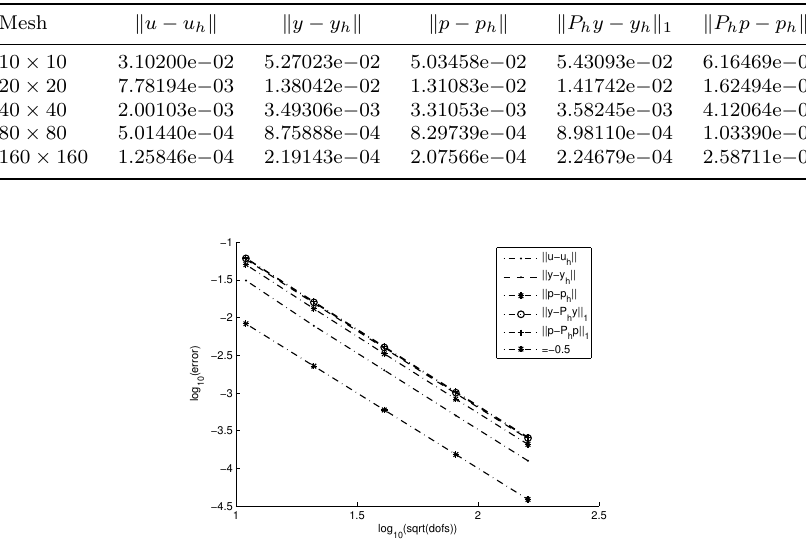
Table 1. Numerical results, Example 1.